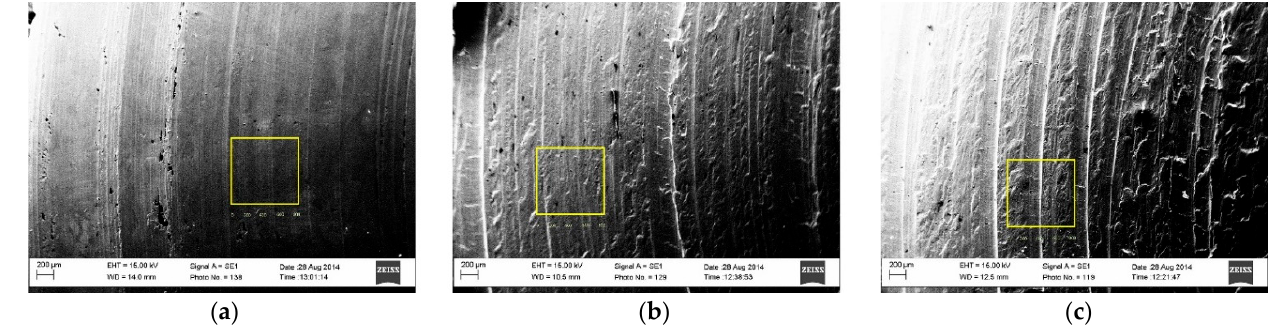
Figure 9. Surfaces of 38KhN3MFA steel samples after turning during LCL cutting (selected areas for visualization—800 from 800 μ m): LCL s ( a ); LCL r ( b ); LCL o ( c ). Areas from which the reconstructions of 2D and 3D surfaces were produced, taking into account the value of the surface roughness, are marked in yellow. From Figures 10–12, it can be seen that cutting with LCL s and LCL r resulted in a smoother and more “even” surface. The roughness was in the range of 4.4 to 6.5 microns. The color ranges for LCL s and LCL r were more uniform (Figures 10a and 11a) than for LCL o , where, in addition to green and blue colors, there were red and yellow colors (Figure 12a). To reproduce the microrelief of the surface treated with LCL s , a smooth surface with a small difference in roughness corresponding to − 1 μ m to +2 μ m (shown in green color with the largest peaks corresponding to +2 µ m) was obtained, and the blue surface corresponds to − 3.0 to − 6.0 µ m (Figure 10a,b). The color ranges for LCLs and LCL r were more uniform (Figures 10a and 11a) than for LCL o , where, in addition to green and blue colors, there were red and yellow colors (Figure 12a). The largest peaks during processing with LCL r reached sizes of up to +7 µ m and were distributed over the entire surface very evenly (Figure 11a,b). The microrelief of the reverse surface in the left part of the image was in the range from − 2 µ m to +2 µ m and had a more or less uniform distribution, indicated by the green color scale. The right part of the image is shown in blue-green colors, which correspond to − 2